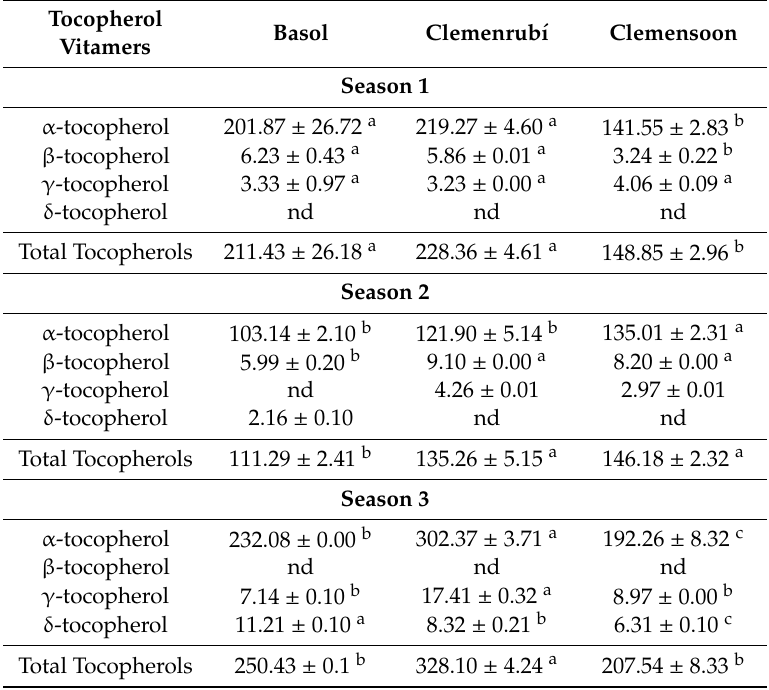
Table 7. Tocopherols content ( µ g / 100 g fw of fruit edible portion) in extra early clementine varieties (mean ± SD, n =